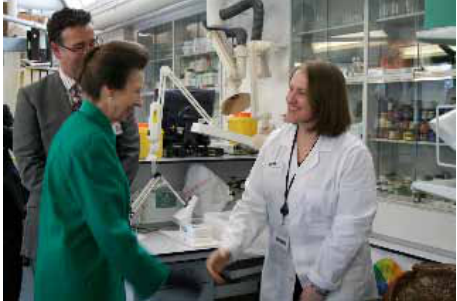
Fig. 5: The Princess Royal, as Chancellor